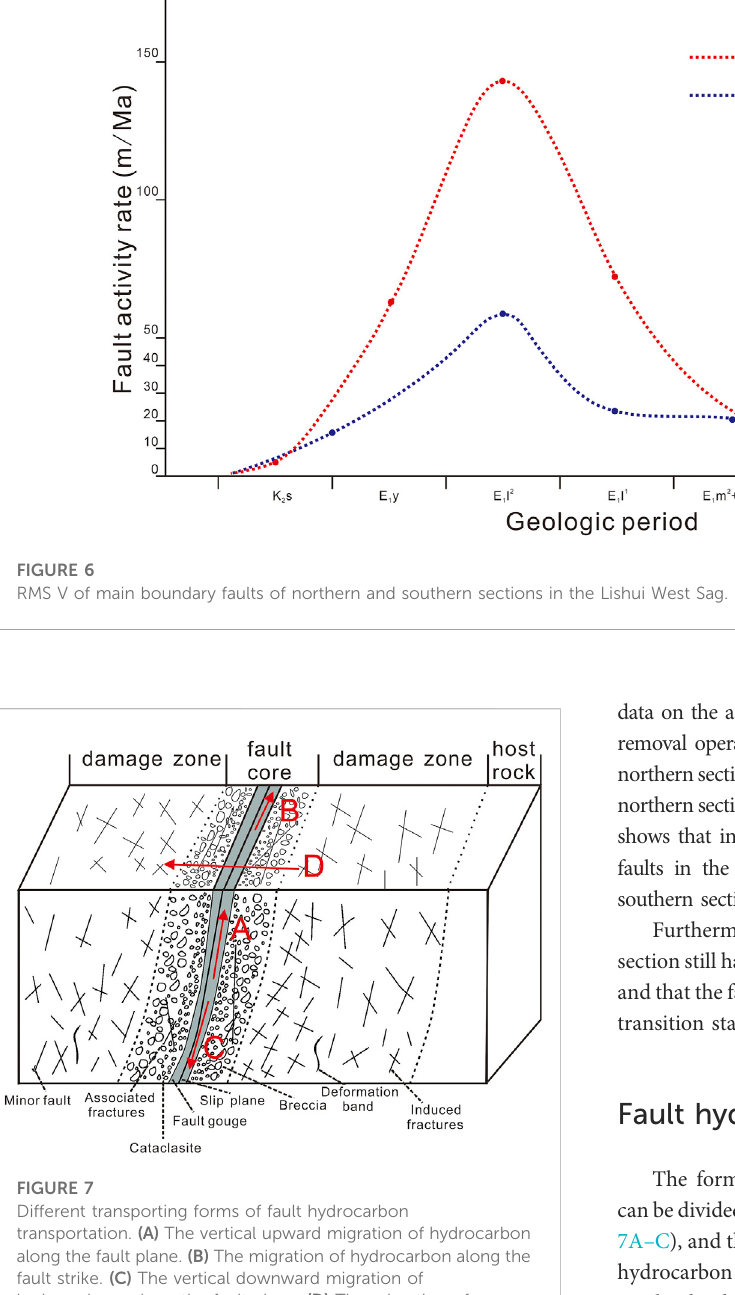
FIGURE 7 Different transporting forms of fault hydrocarbon transportation. (A) The vertical upward migration of hydrocarbon along the fault plane. (B) The migration of hydrocarbon along the fault strike. (C) The vertical downward migration of hydrocarbons along the fault plane. (D) The migration of hydrocarbon through the fault